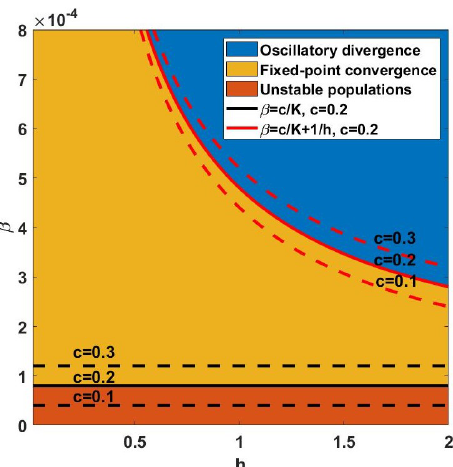
Figure 3. Stability regions of the discrete Ricker-type model and discrete Lotka-Volterra model as a function of h and β = αγ , K = 2500 and r = 0.5. The fixed-point convergence region is bounded + 1 by β = c and β = c , and boundary changes are marked in red and black lines for different K K h c = { 0.1,0.2, 0.3 } . The stability regions are coloured for c = 0.2, as represented in solid lines, and are represented as dashed lines for c = 0.1 and c =